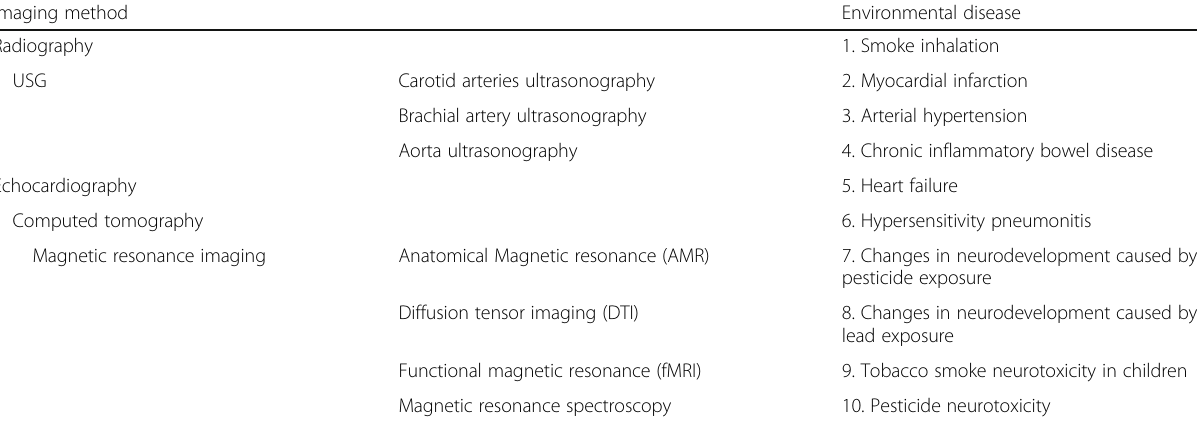
Table 2 Imaging methods used in the evaluation of diseases associated with exposure to environmental pollution Imaging